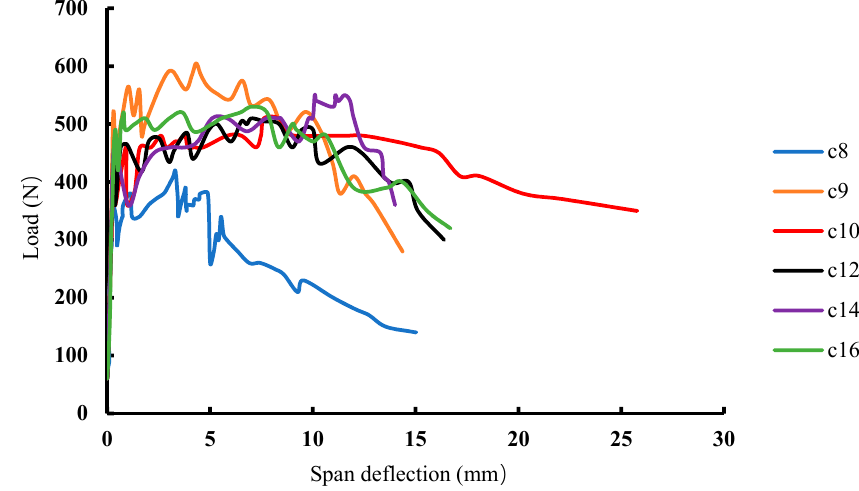
Figure 13. The load-deflection curves of SSPP-ECC.